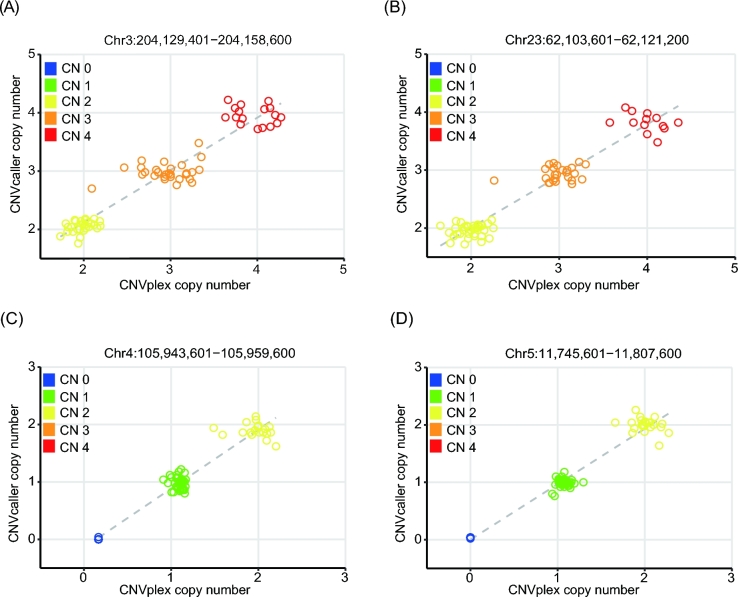
Evaluation of the sheep CNV genotypes by CNVplex. Two duplicated (A, B) and 2 deleted (C, D) CNVRs with a high variation frequency were typed in CNVplex using 73 sheep samples. The copy number genotypes predicted by CNVcaller from the sequencing data were plotted against the CNVplex measurements of the same animal.